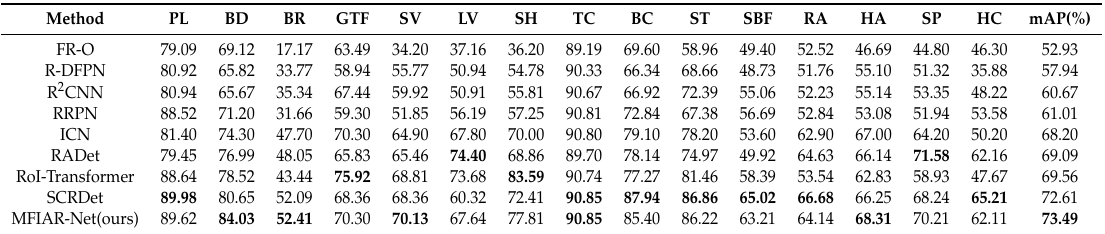
Table 1. Comparison of the performance on OBB task with the state-of-art methods on DOTA test set. The numbers in boldface indicate the best detection results on each